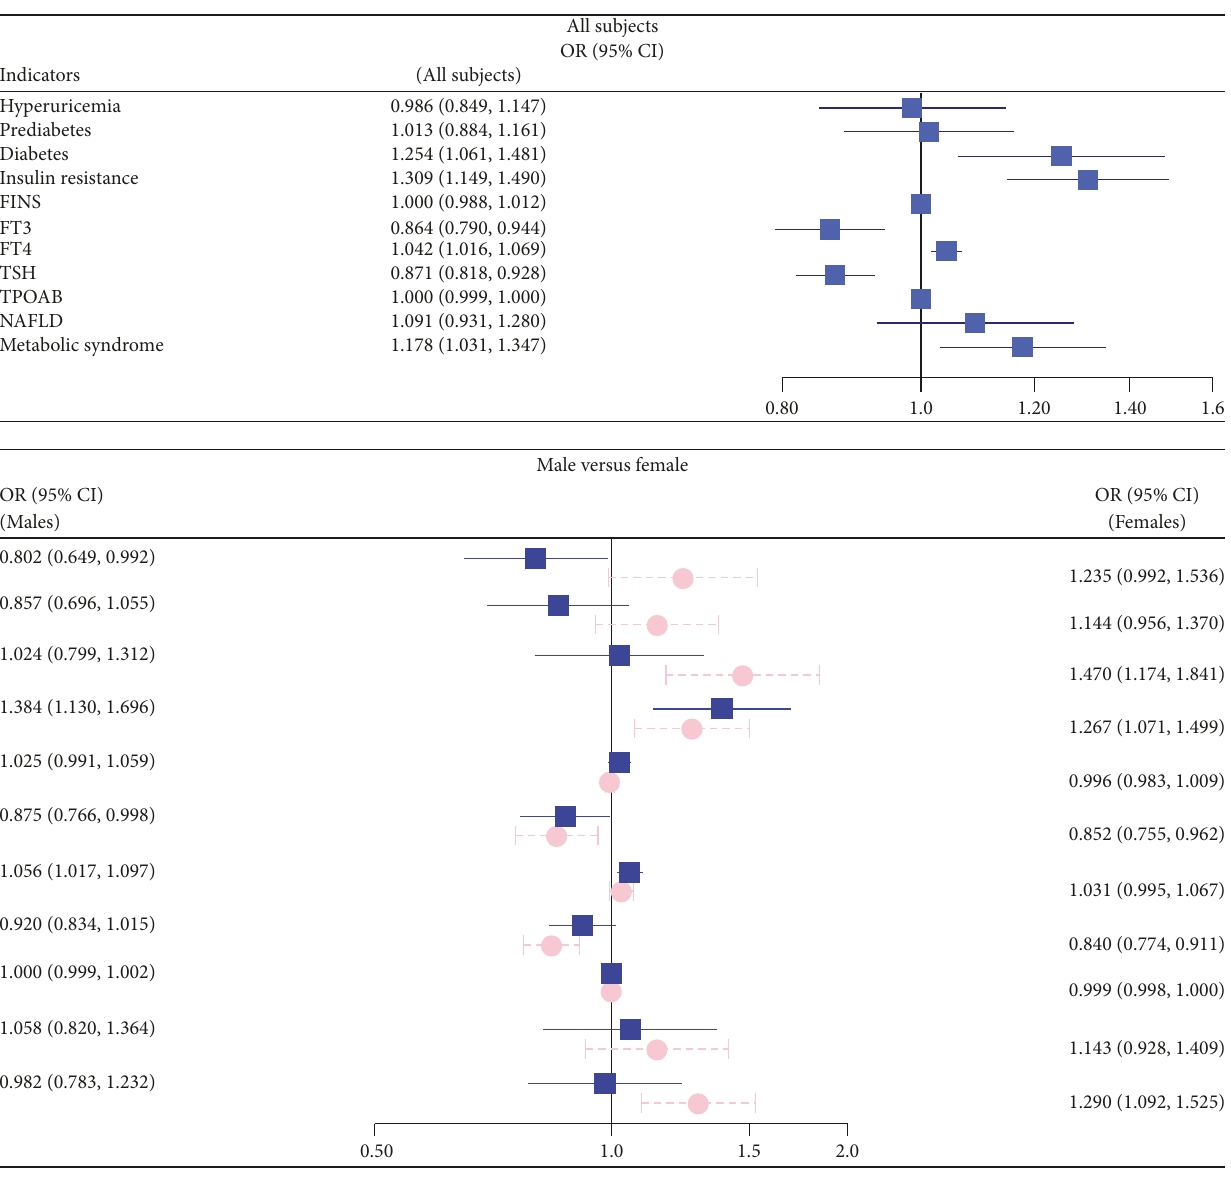
Figure 1: Metabolic risk factors of thyroid nodules were analyzed using logistic regression in total, male and female subjects. Adjustment of age, drinking, smoking, and family history of thyroid disease; FINS, fasting plasma insulin; FT3, free triiodothyronine; FT4, free thyroxine; TSH, thyroid-stimulating hormone; TPOAB, thyroid peroxidase antibody; NAFLD, nonalcoholic fatty liver